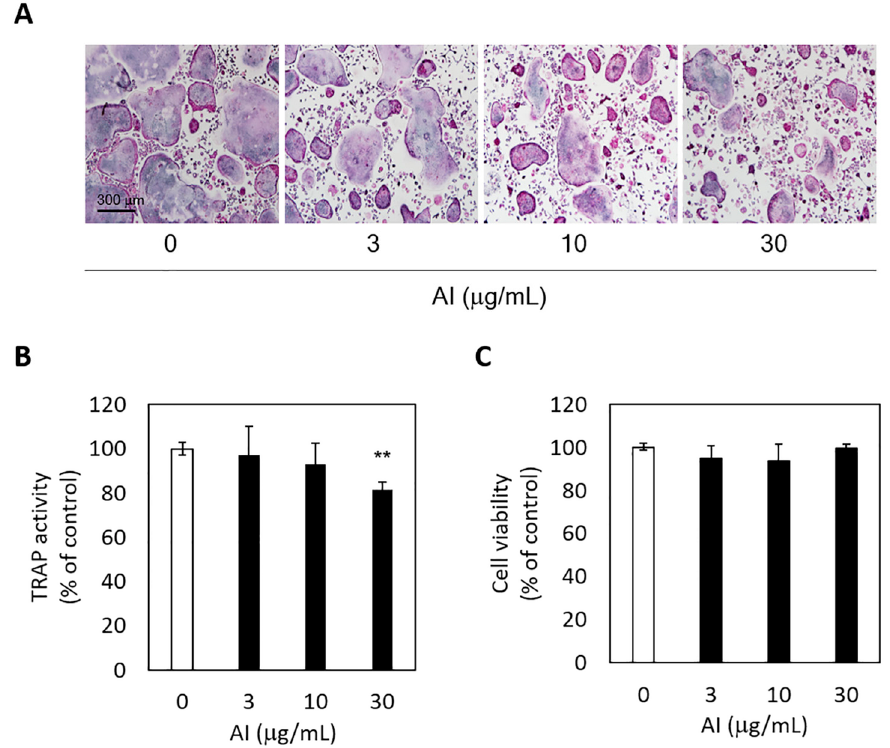
Figure 4. Asplenium incisum (AI) suppresses receptor activator of nuclear factor kappa-B ligand (RANKL)-induced osteo-